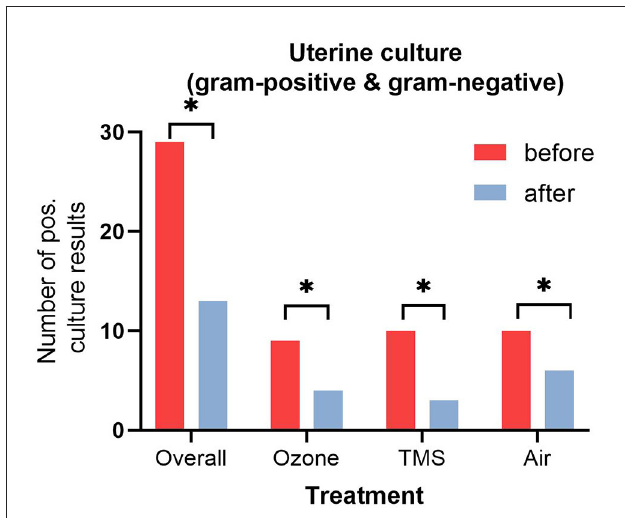
FIGURE2 Number of positive uterine culture results (gram-positive and gram-negative bacteria) before and after treatment. Asteriks ( * ) indicate significant difference between pre- and post-treatment results as determined by non-parametric U -test (Wilcoxon; p < 0.05).